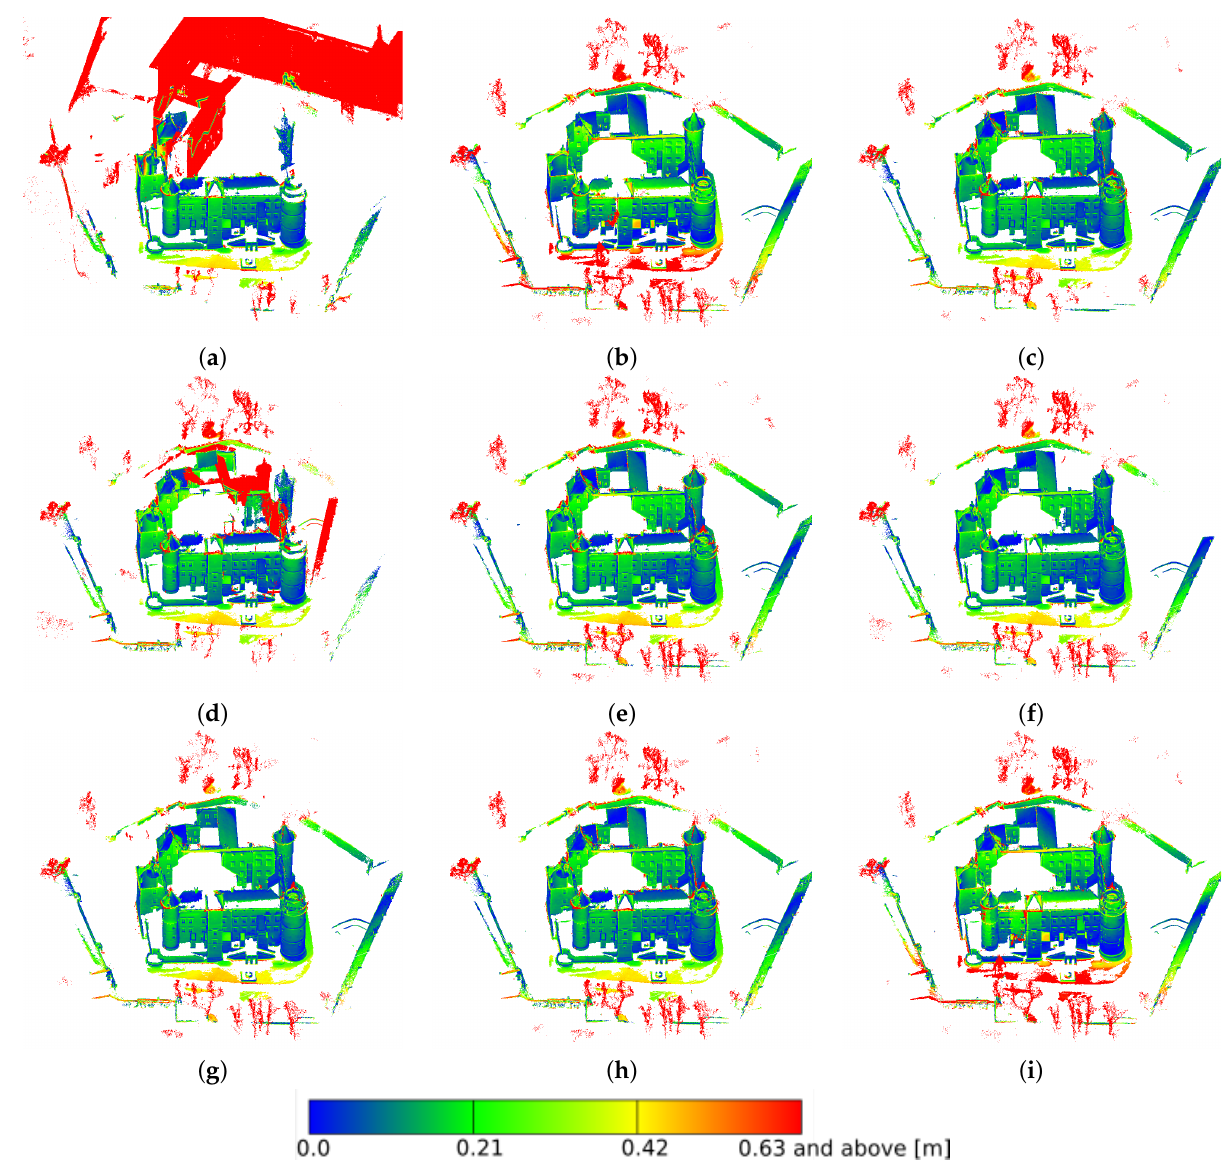
Figure 19. Dense point clouds of the castle. Distances to the model up to 3 σ = 0.63 m: ( a ) original; preprocessed in the RGB space with the use of: ( b ) histogram stretching, ( c ) histogram equalizing, ( d ) adaptive equalizing, ( e ) exact histogram matching; preprocessed in the L*a*b* space with the use of: ( f ) histogram stretching, ( g ) histogram equalizing, ( h ) adaptive equalizing, ( i ) exact histogram